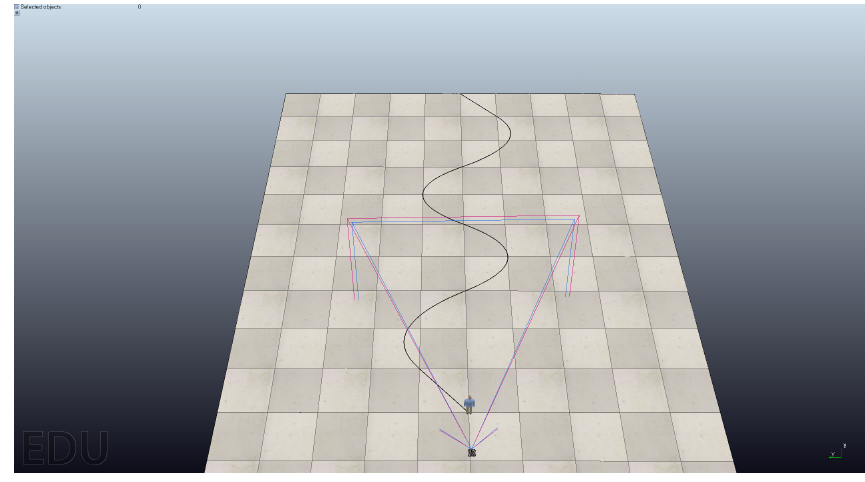
Figure 6. The unseen test scenario.